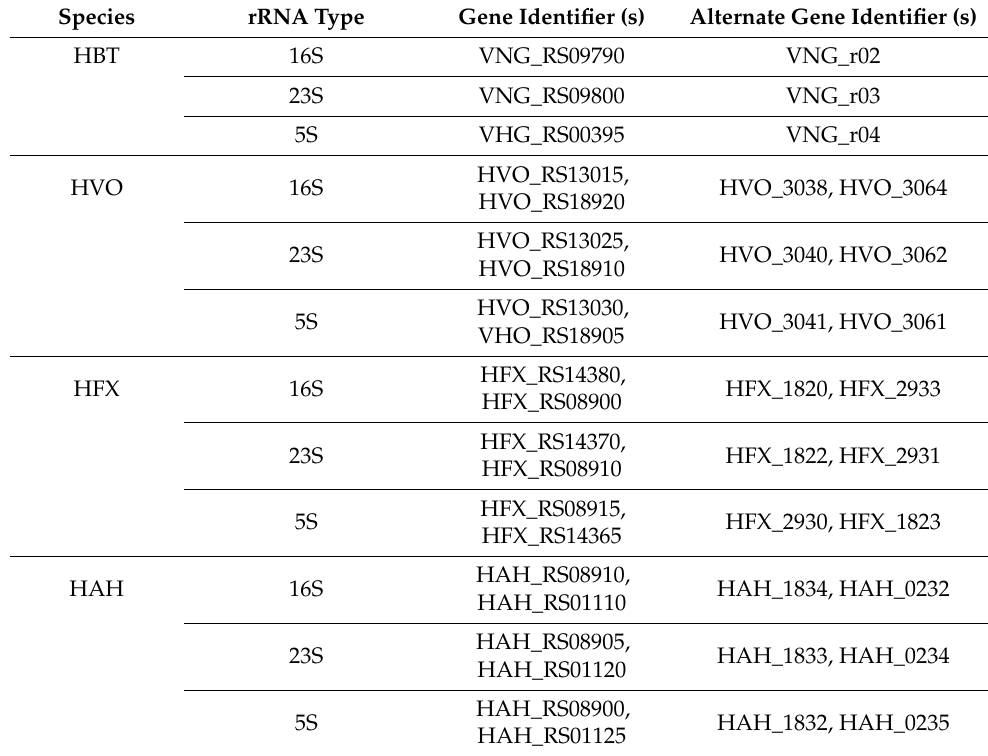
Table 5. rRNA-coding gene identifiers for each species of